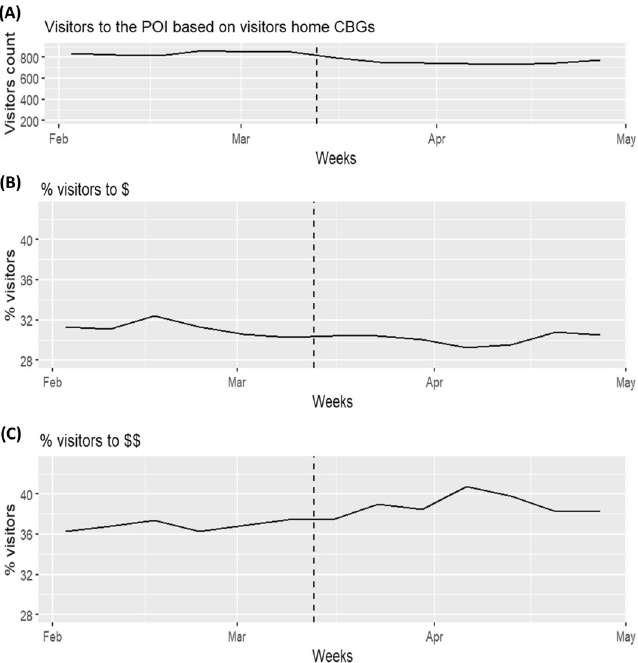
Figure 1. ( A ) There were moderate drops in total visits to grocery stores at the beginning of the pandemic, with a partial bounceback, accompanied by ( B ) a drop in the percentage of visits to one-dollar sign stores and ( C ) an increase in the percentage of two-dollar sign